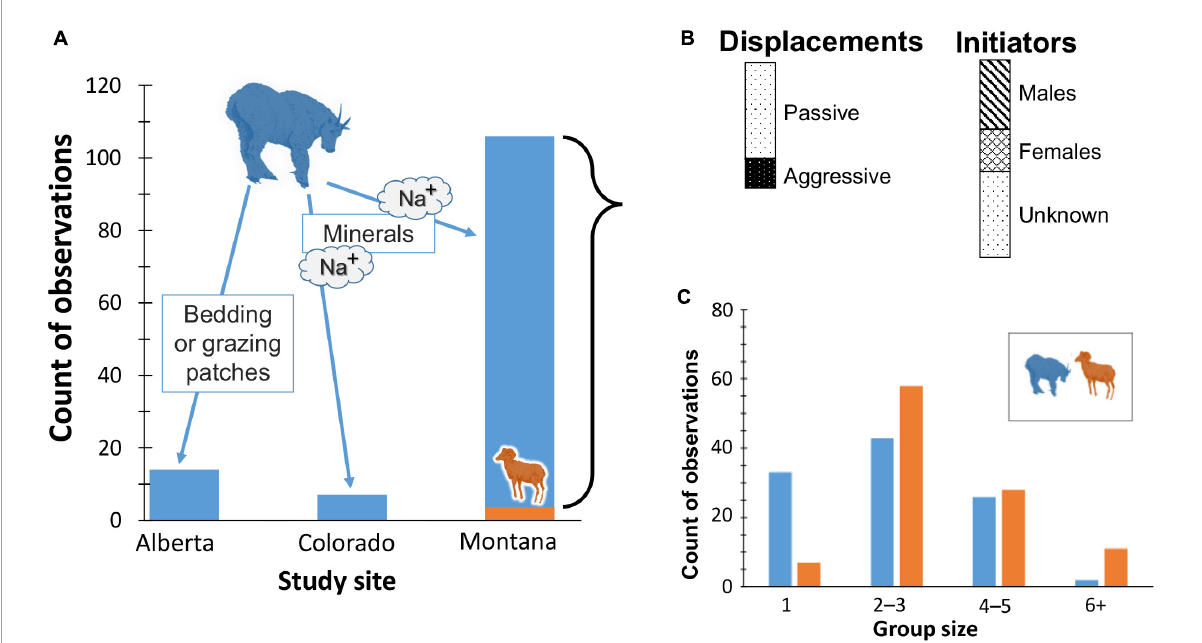
FIGURE4 Outcomes of dominance assertion between mountain goats and bighorn sheep. (A) Histogram in which blue column (goats) is % of encounters won relative to orange (sheep), by study site with those in Alberta, Canada for space or food, and in Colorado for micro-nutrients. (B) Relative proportions of goat-initiated displacements of sheep by type (as defined in Methods), and of known sex; (C) distribution of goat and sheep group